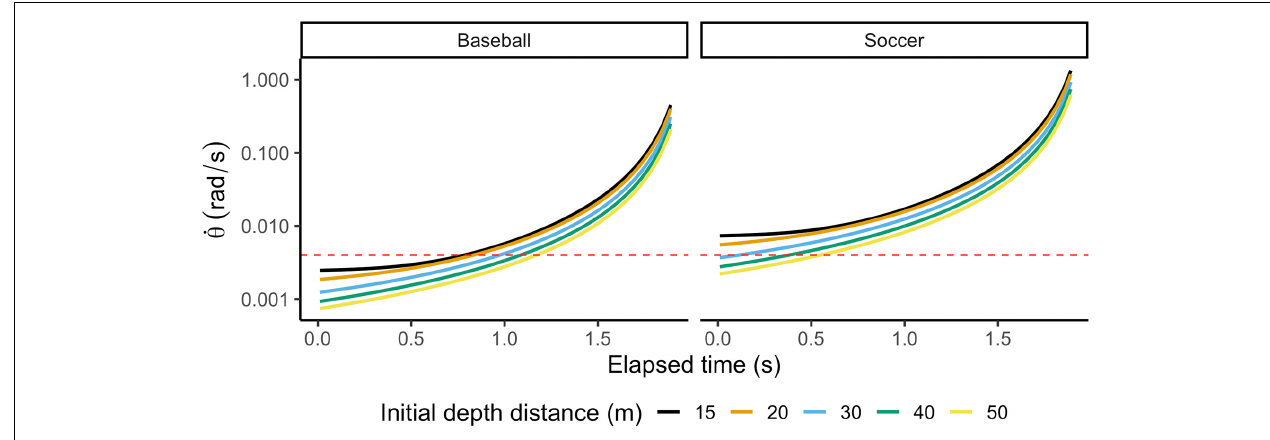
FIGURE 3 | Rate of expansion ( ˙ θ ) for two different ball sizes at five different initial distances. The total flight time is 2 s. Values under the red dashed line (0.004 rad/s) indicate that an observer cannot discriminate